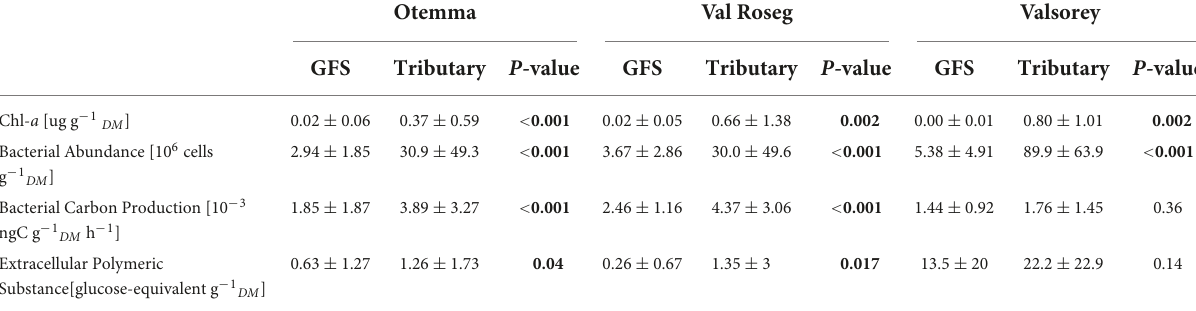
TABLE 2 Biomass indicators for each glacier floodplain and stream type (mean ± standard deviation).